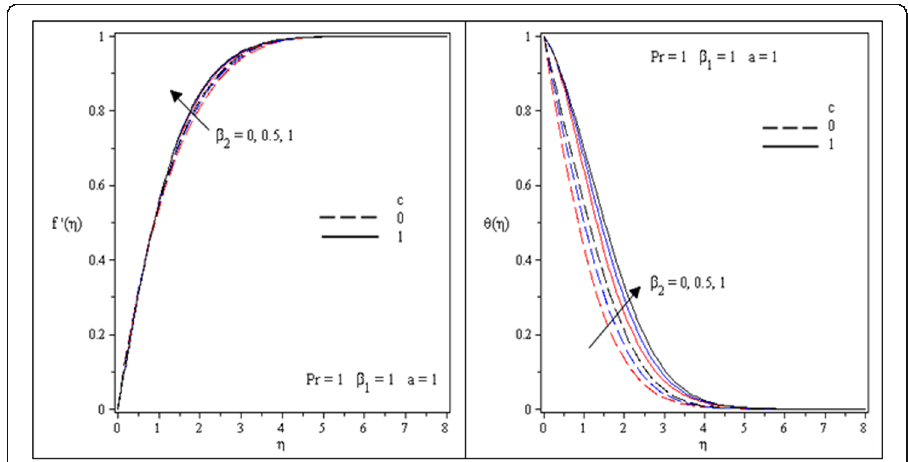
Fig. 4 Velocity and temperature profiles for the thermal conductivity parameter with and without IHG